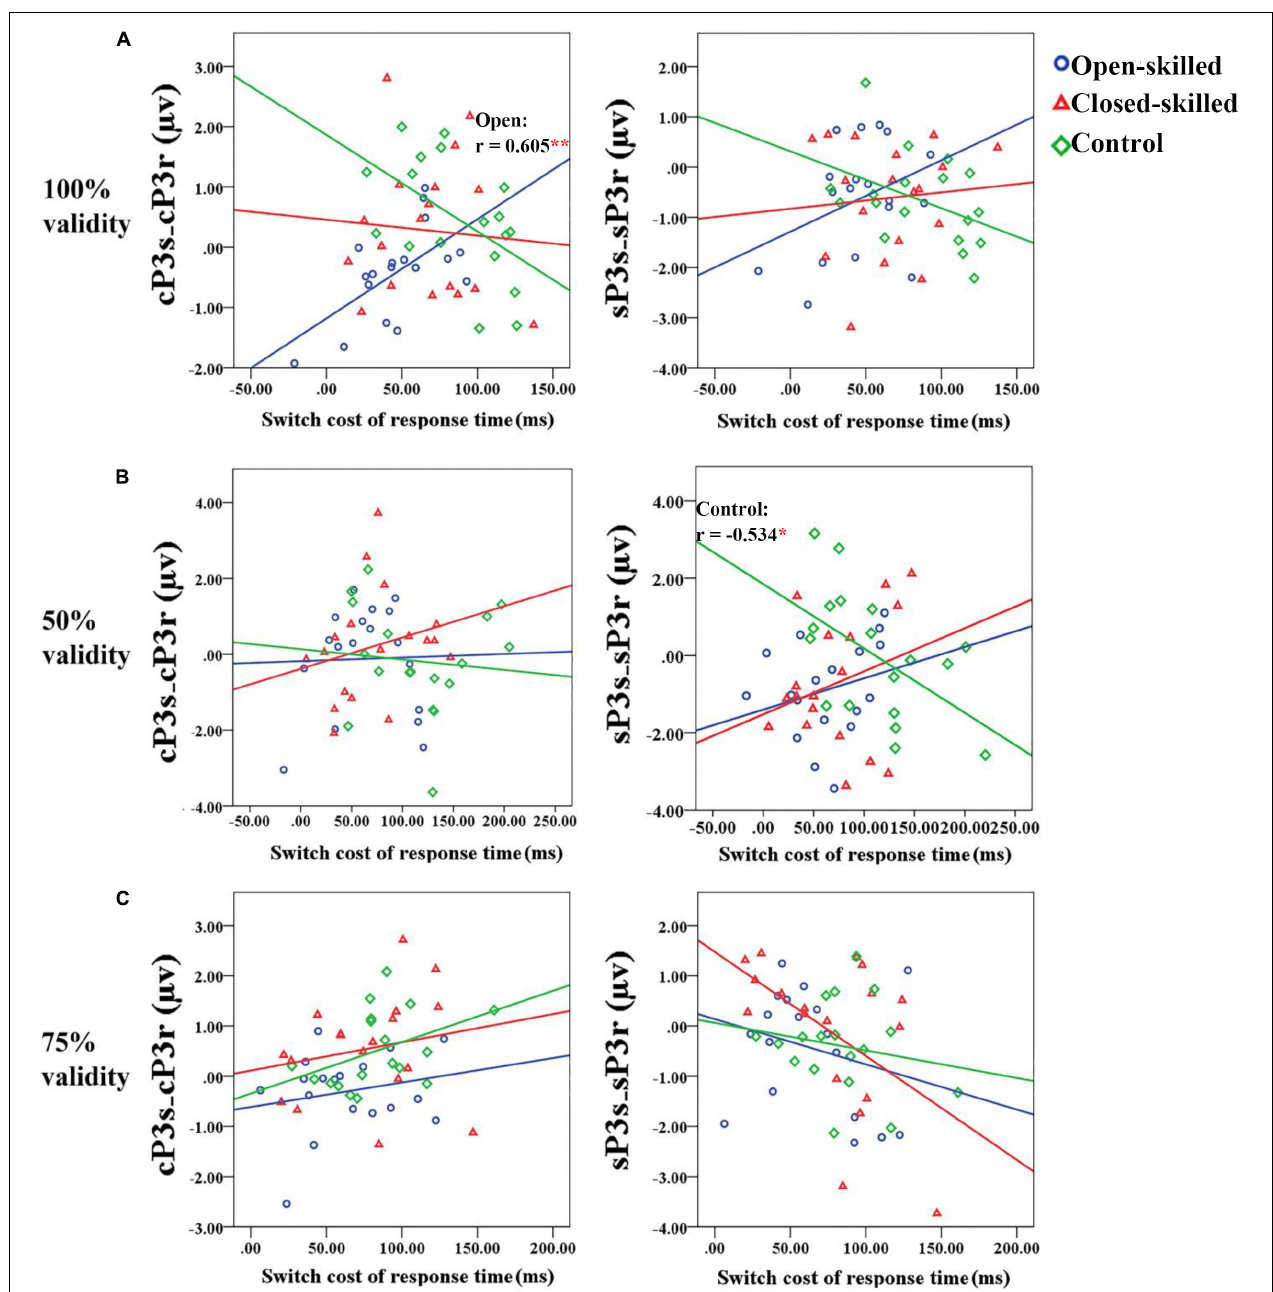
FIGURE 6 | Scatter plots showing the relationships between the differences of the mean amplitudes of the cue-locked P3 between switch and repeat trial-types (cP3 S -cP3 R ) (right panel) or that of the stimulus-locked P3 (sP3 S -sP3 R ) (right panel) and the switch cost of response time for the 100, 50, and 75% validity conditions (from a to c) among the three groups of participants. (A) In the 100% validity condition, one significant correlation coefficient ( r = 0.605, p = 0.008) is revealed in the open-skilled group for the cue-locked P3 (cP3s-cP3r); the blue regression line presents the significant positive correlation between the two variables. (B) In the 50% validity condition, one significant correlation coefficient ( r = –0.534, p = 0.022) is revealed in the control group for the stimulus-locked P3 (sP3s-sP3r); the green regression line presents the significant negative correlation between the two variables. Only control group shows significant correlation. (C) In the 75% validity condition, no significant correlations are revealed. ∗ p < 0.050; ∗∗ p < 0.010.